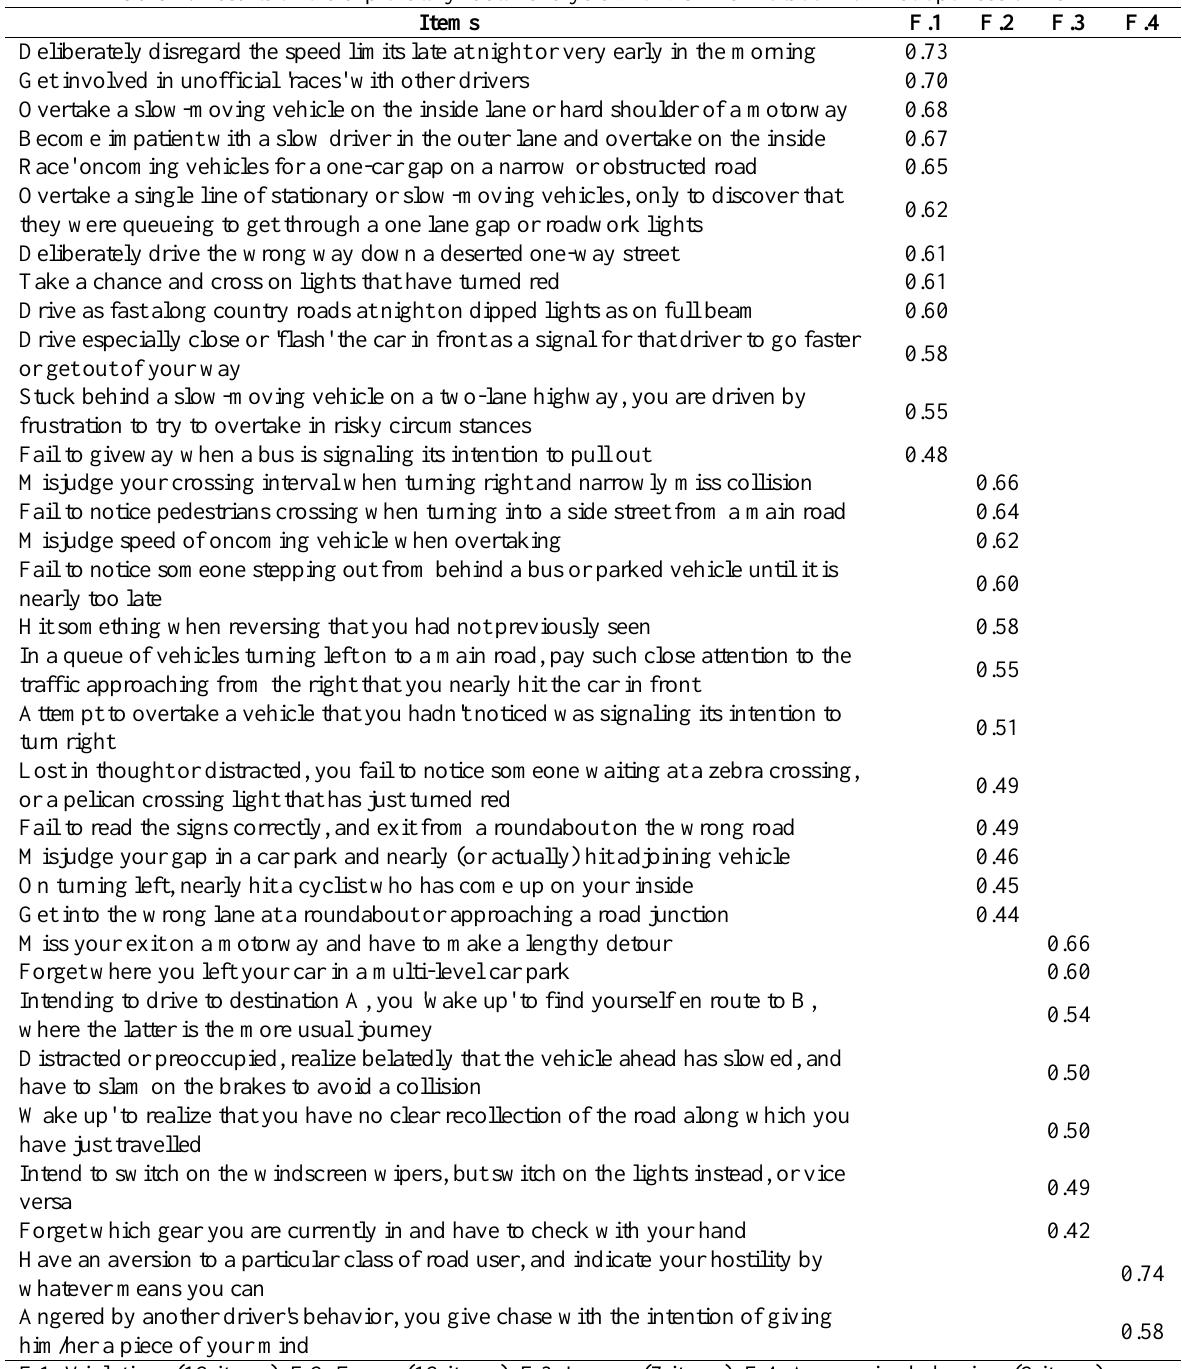
Table 4. Results of the exploratory factor analysis with Varimax rotation for metropolises of Iran